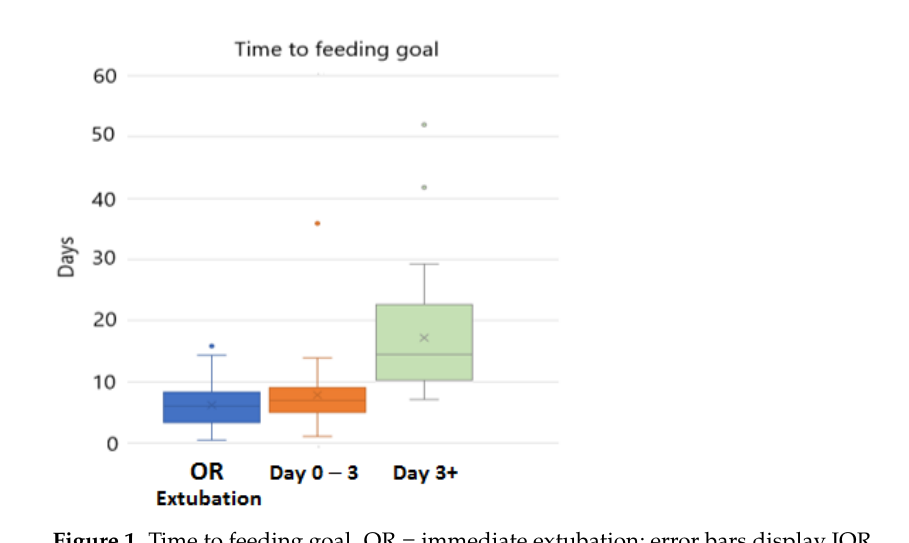
Figure 1. Time to feeding goal. OR = immediate extubation; error bars display IQR. Enteral feeding pre-operatively was associated with a shorter time to goal feeds postoperatively (5.6 days (4.1–7.7) vs. 7.4 days (6.4–11.5), p = 0.036). Males reached goal feeds sooner than females (5.7 days (3.4–7.3) vs. 7.5 (5.9–9.0), p = 0.005). There was no correlation between age (r = 0.06), gestational age (r = − 0.002), weight (r = − 0.03), cardiopulmonary bypass time (r = 0.11), or cross clamp time (r = 0.04) and time to goal feeds. There was no association between time to goal feed volume and post-operative cyanosis (cyanotic 6.3 days (4.9–7.4) vs. non-cyanotic 6.3 days (4.9–7.4), p = 0.95). When comparing the immediate and early groups, there was no difference in length of hospital stay (15.0 days (11.6–19.8) vs. 14.0 days (12.3–18.2), p = 0.30) (Figure 2).